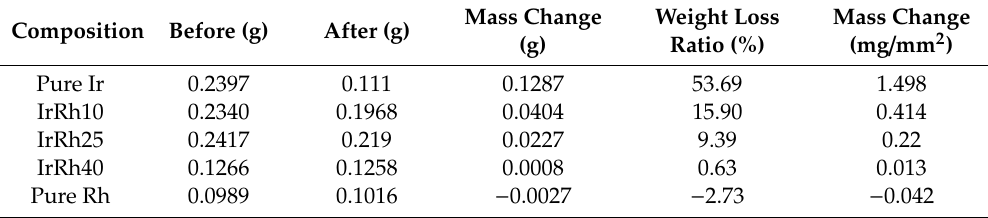
Table 1. Mass change of pure elements for 60 h under 1100 ◦ C oxidation.